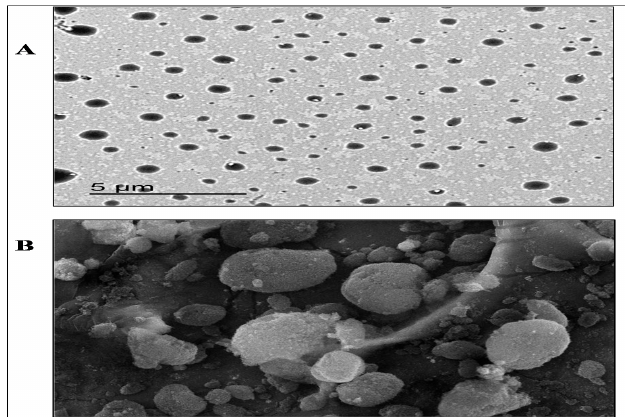
Figure 4. The surface morphology of the optimized formulation of the carbamazepine solid lipid nanoparticles (F8). ( A ) Transmission electron microscopy image and ( B ) scanning electron microscope image ( × 500).